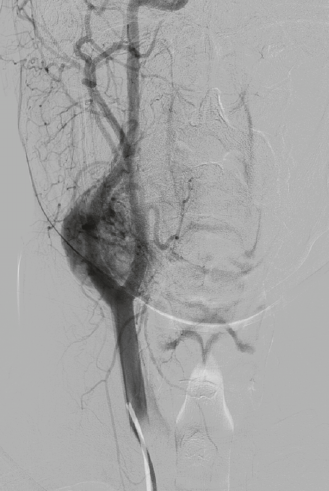
Figure 6: Digital subtraction angiography (DSA) revealed a carotid body paraganglioma in the right carotid